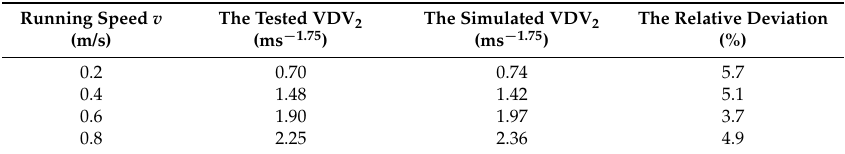
Table 3. A comparison of the calculated values of VDV 2 for the wheelchair going down the step. Running Speed v The Tested VDV 2 The Simulated VDV 2 The Relative Deviation (m/s) (ms − 1.75 ) (ms − 1.75 ) (%)